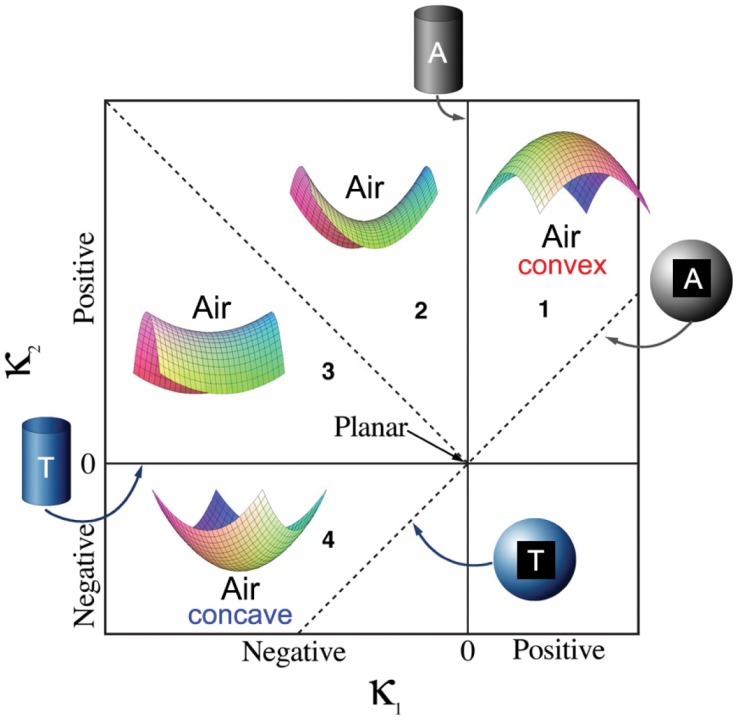
Interface shape distributions map.Interface shape distributions (ISD-plot) schematic, adapted with permission from J.L. Fife [25]. It represents a 2D probability density plot in dependence on the the minimum curvature κ1 and the maximum one κ2 for each vertex on the mesh. It gives a graphical representation of how interfaces are shaped within the investigated 3D volume. The four regions (1–4) are explained as follows: κ1, κ2 > 0 (region 1) represent ellipsoidal surfaces (being convex toward the lung tissue); κ1, κ2 < 0 (region 4) indicate concave ones; and regions 2 and 3 represent so-called hyperbolic (or saddle) surfaces. The color code (blue = concave, red = convex) of regions 1 and 4 is the same as in Fig 13, while “A” and “T” denote cylindrical/spherical surface shapes of “air” and (lung) “tissue”, respectively.